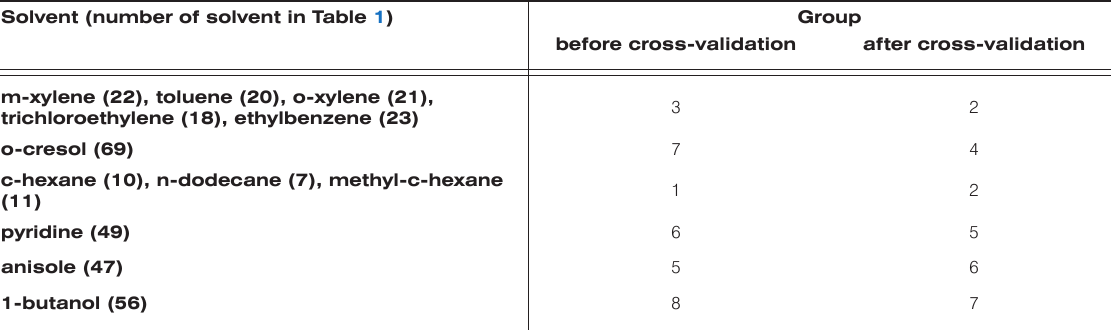
Table 6. Results of the leave-one-out cross-validation. Solvent (number of solvent in Table 1)